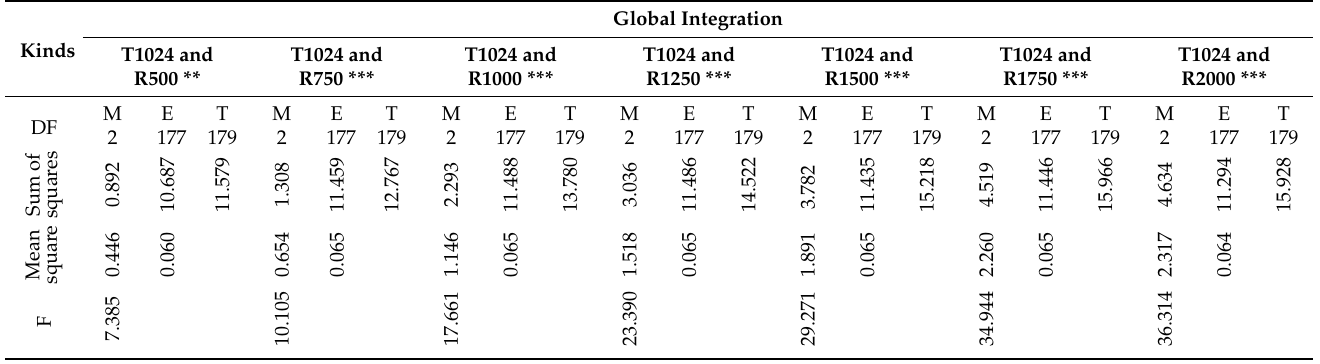
Table 6. Global integration and through angle and limit distance range